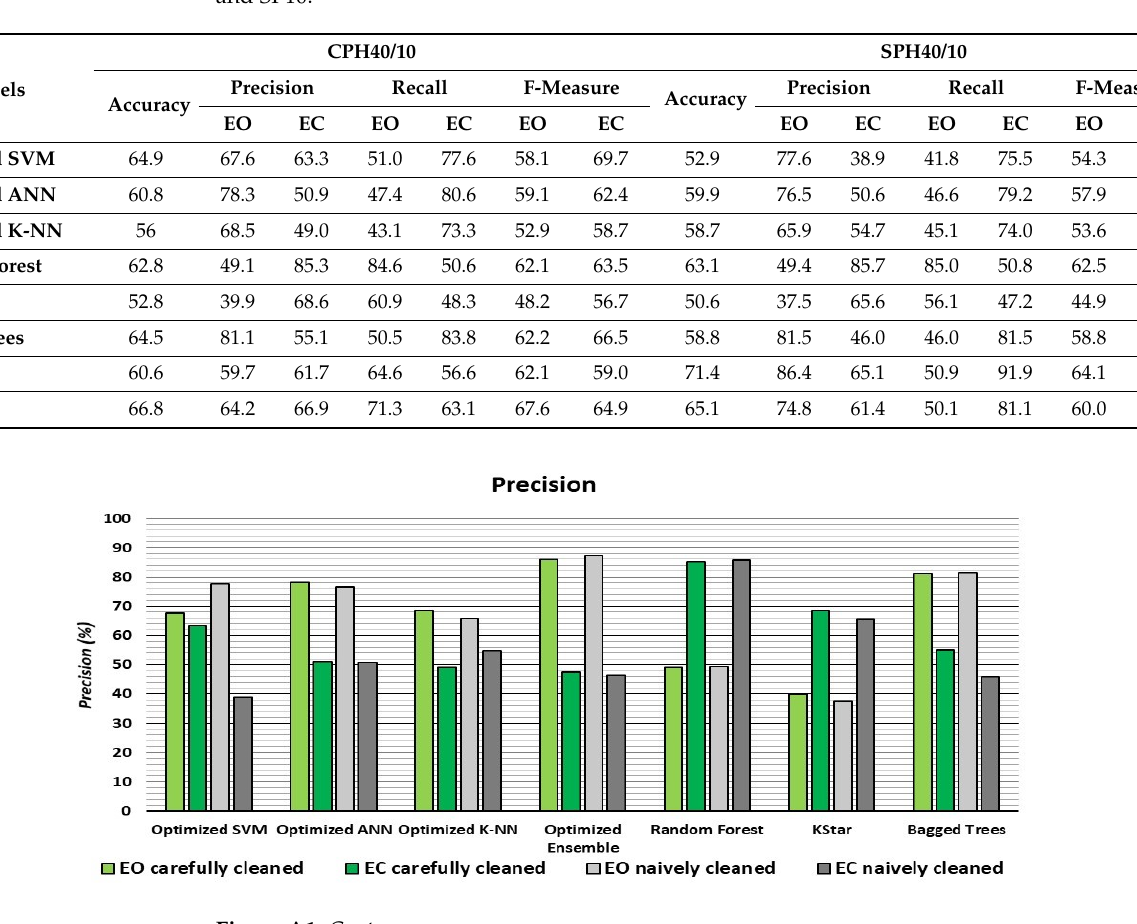
Figure A1. The precision, recall and F-measure for the comprehensively preprocessed and simply preprocessed data, with the classifiers trained on the data derived from 40 subjects and tested on the data derived from the withheld data of ten subjects. References 1.